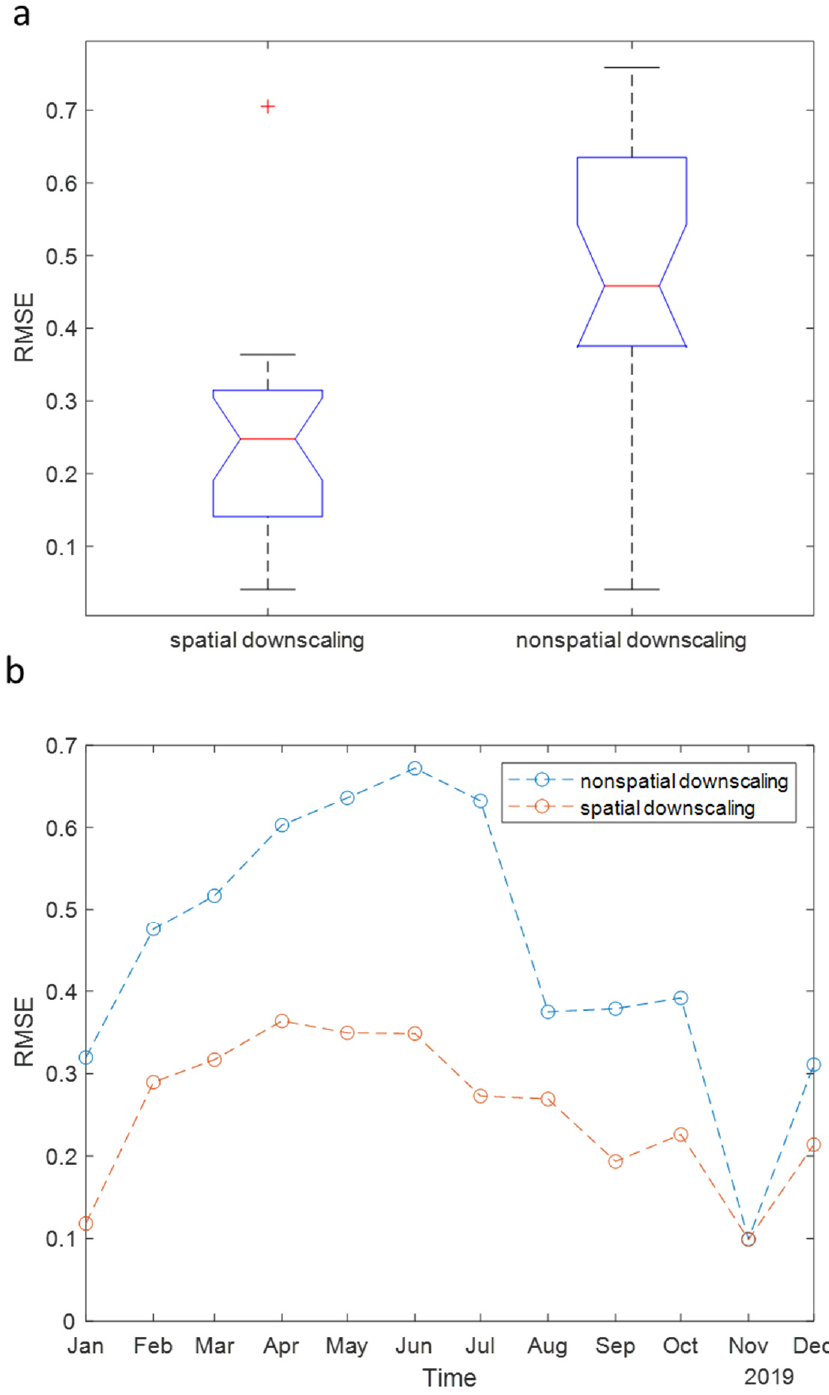
Figure 3. ( a ) RMSE boxplots comparing spatial and nonspatial downscaling of SPI 6 in 2018 and 2019 (during drought periods). ( b ) RMSE time series comparing spatial and nonspatial downscaling of SPI 6 in 2019.